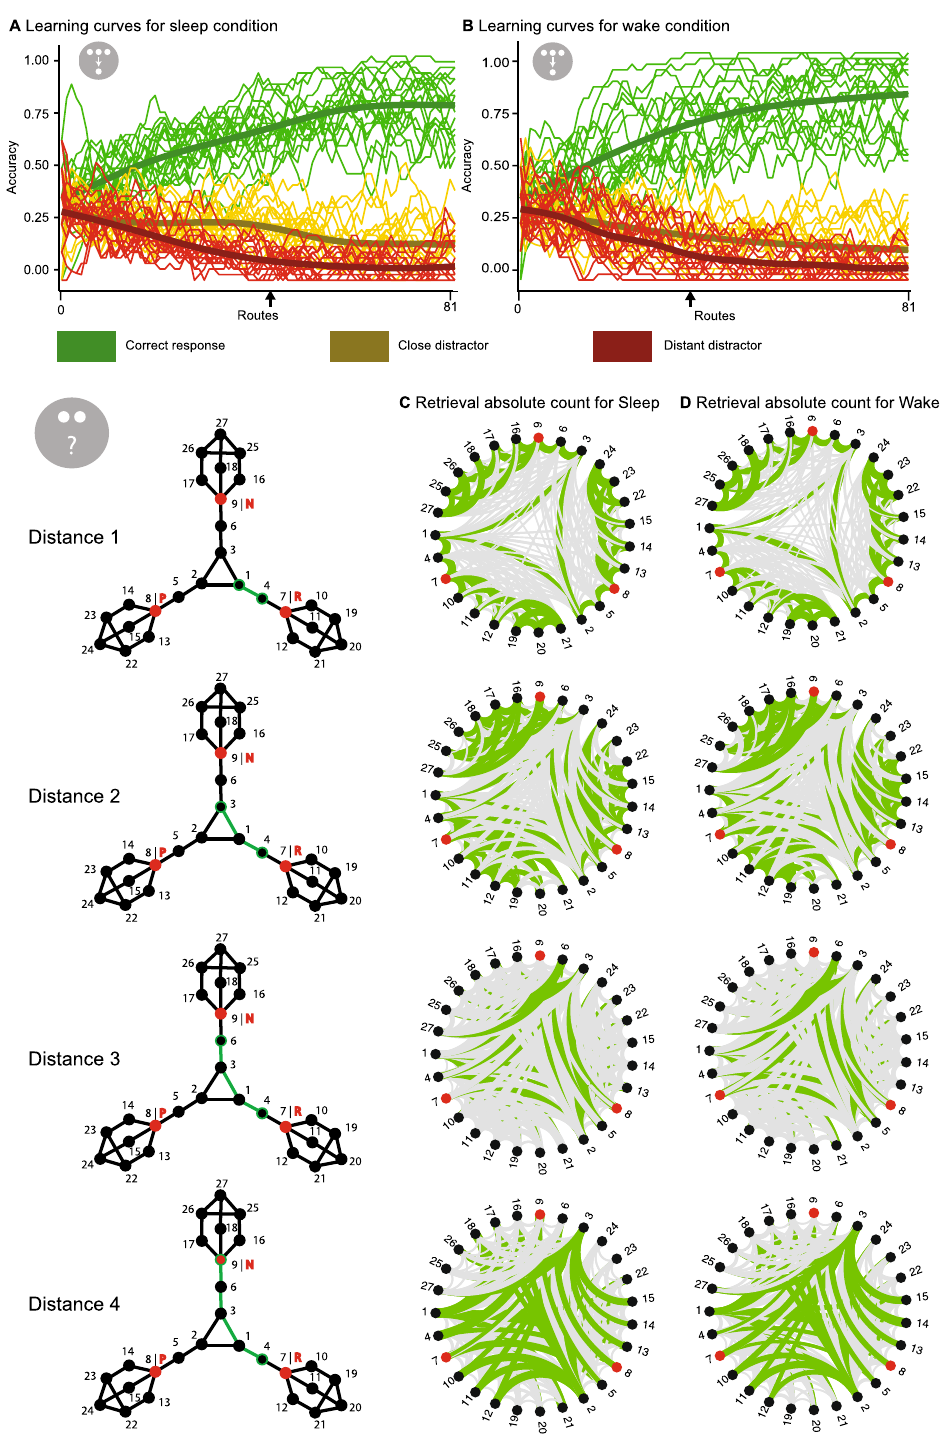
Figure 3. Participants’ raw learning and retrieval data. ( A ) Learning curve across the 81 routes for the sleep and ( B ) the wake condition. Mean (thick line) and individual responses (thin lines) for correct response (green), the close distractor (yellow) and the distant distractor (red) smoothed by a five point moving average. The black arrow indicates when participants’ performance was significantly biased by the graph structure (i.e., accuracy of the close and distant distractor started to differ). ( C ) Retrieval task data for each distance (rows) in the sleep and ( D ) the wake condition. On the left the graph structure and an example (in green) is shown for each distance, which is defined by the number of edges between the pair of nodes tested. Within the circles, green lines represent correct connections and grey lines correspond to incorrect connections at that distance, whereas line thickness depicts how many participants gave the respective